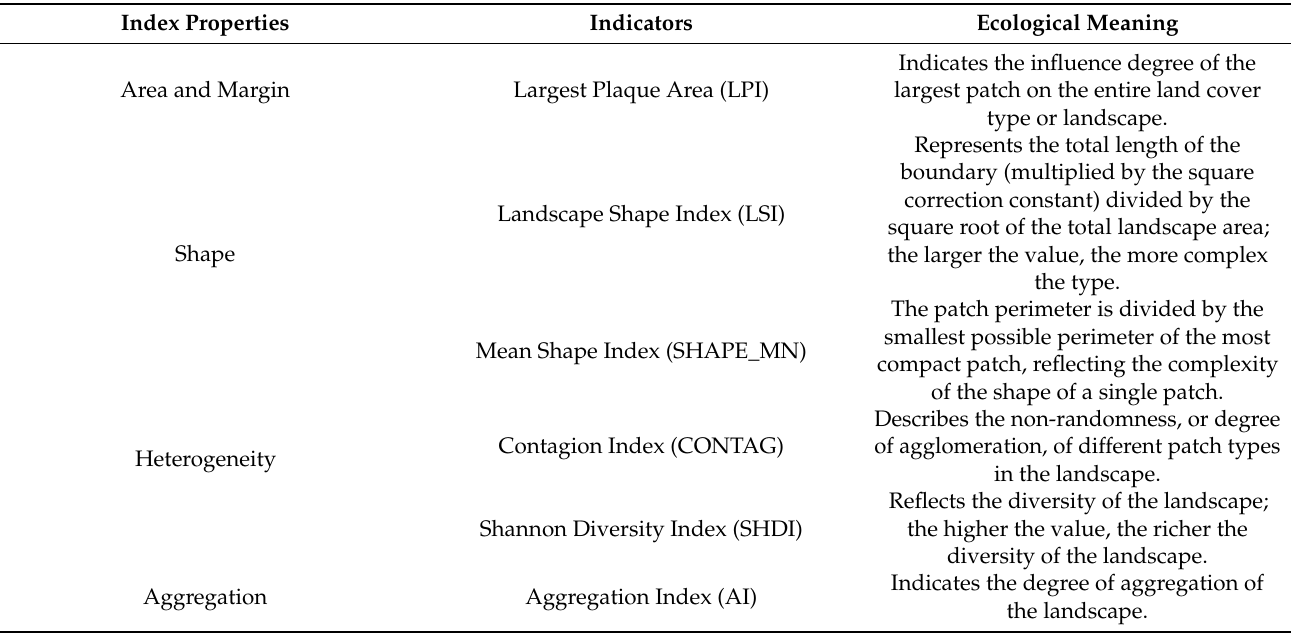
Table 1. Ecological meanings of the selected landscape